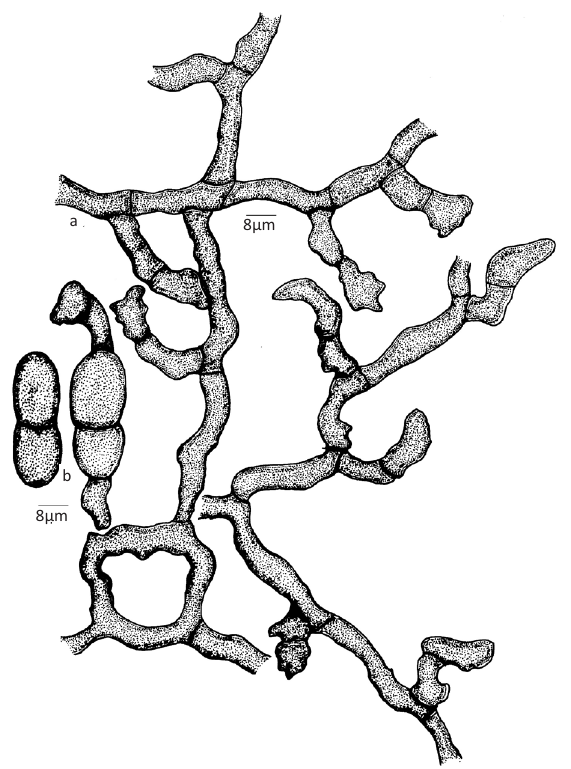
Figure 1. Armatella apollonigena sp. nov. a - Appressoriate mycelium; b -